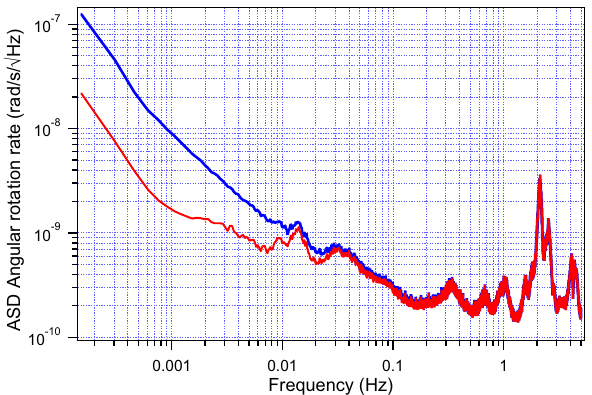
Fig. 2 Comparison of the old and new analysis of GINGERINO data. Blue trace: standard method with Hilbert transform; red trace: data corrected using Eq. 14 neglecting ω s ξ ; green trace: data corrected after fitting for parameter ξ (Eq. 15, in the fit ξ = 0 . 16)